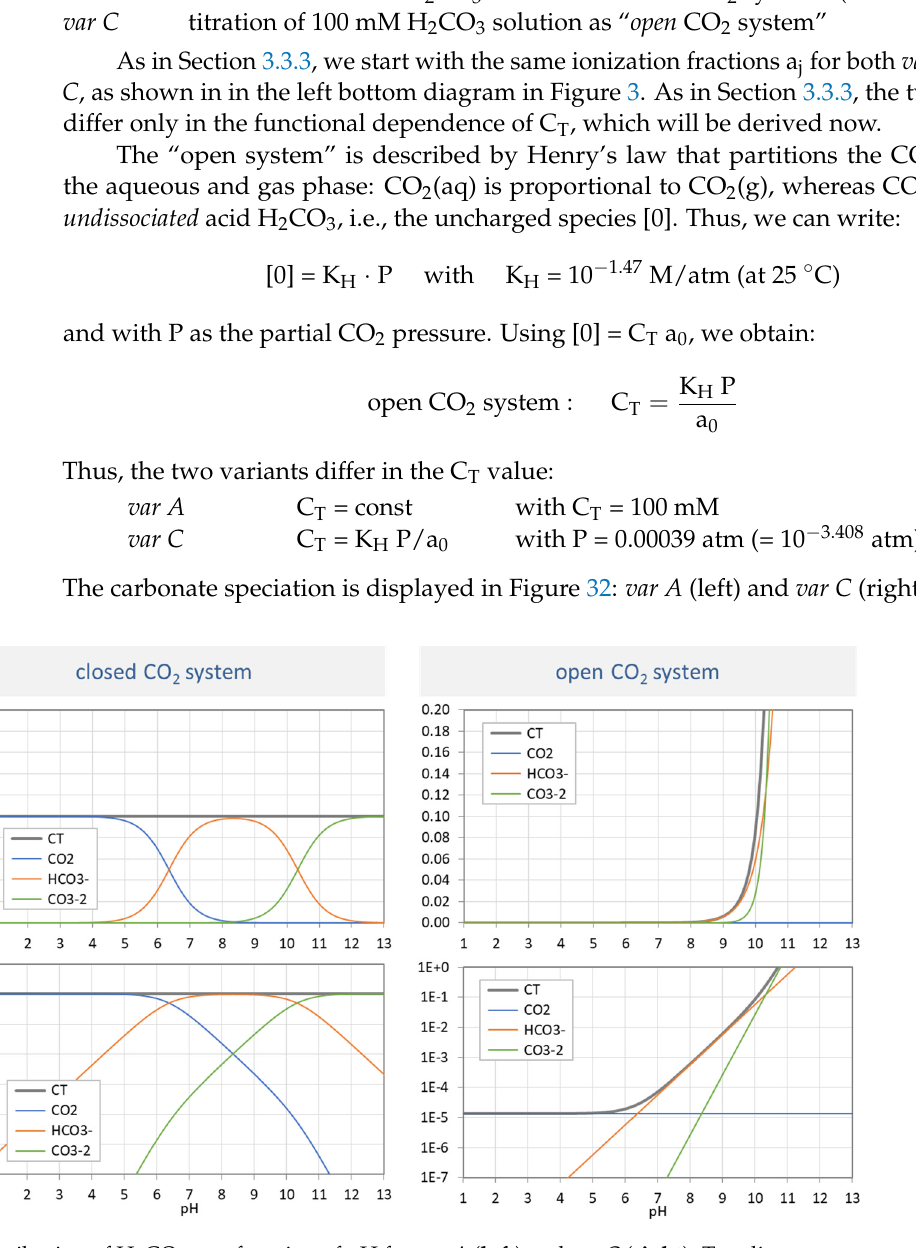
Figure 32. Species distribution of H 2 CO 3 as a function of pH for var A ( left ) and var C ( right ). Top diagrams: concentrations in linear scale; bottom diagrams: logarithmic scale.